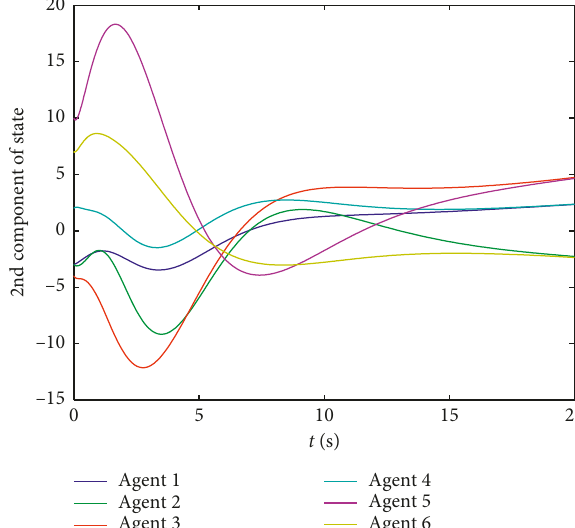
Figure 5: Trajectories of x